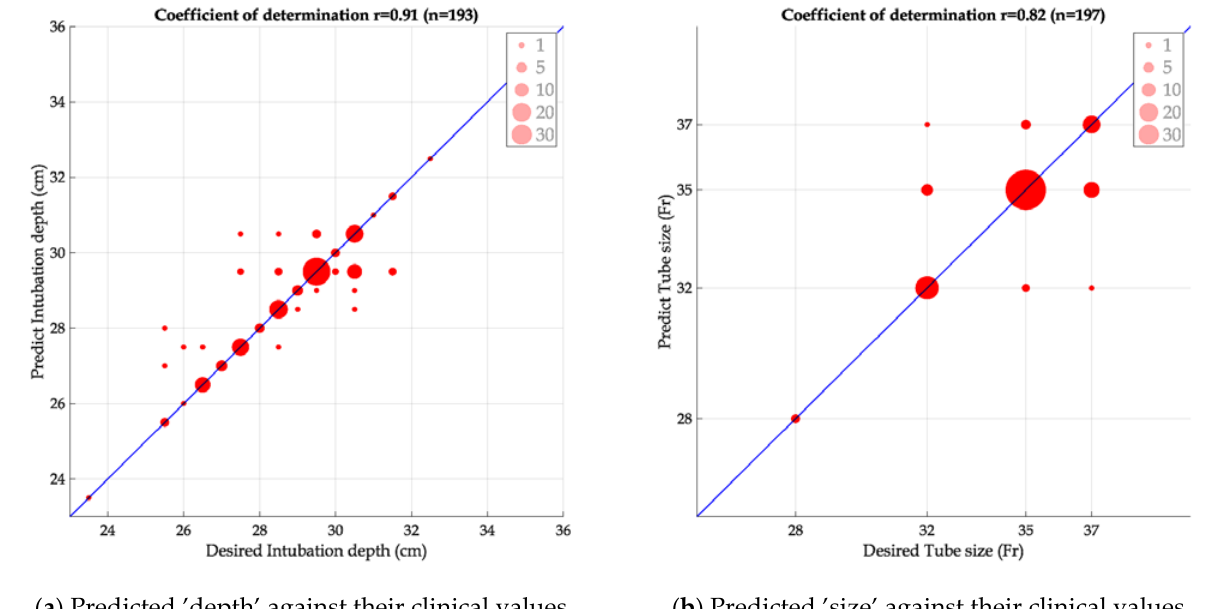
Figure 8. Scatterplots of predicted values of ‘depth’ or ‘size’ against their clinical values. Note that numbers of subjects are different between two panels, as ‘depth’ and ‘size’ were modeled separately.